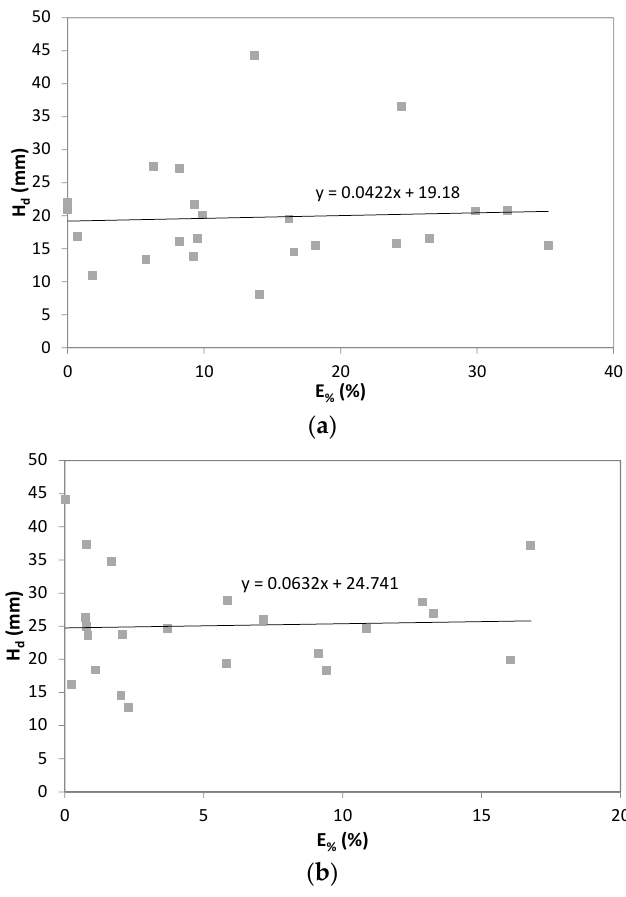
Figure 11. Relation between annual maximum rainfall depth, H d , and underestimation error, E % . ( a ) San Biagio della Valle station, t a = d = 30 min. ( b ) Compignano station, t a = 15 min and d = 30 min. The best interpolating linear function is also plotted.